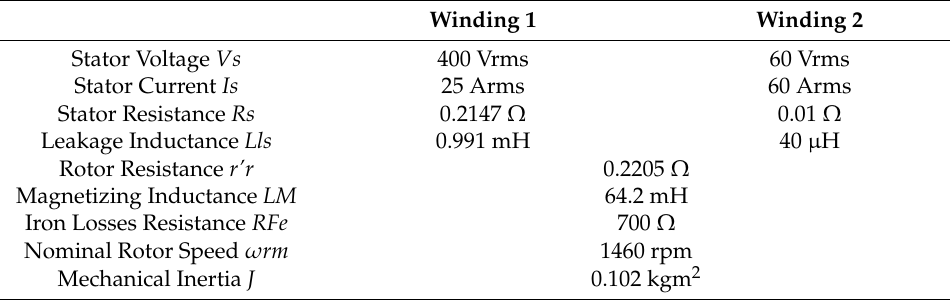
Table 1. Multi-winding induction motor